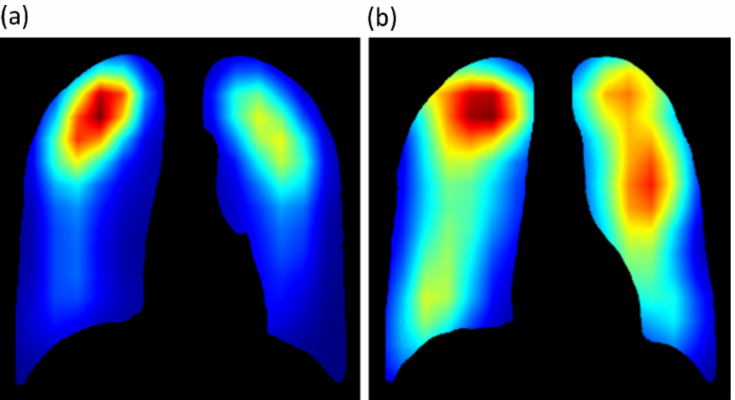
Figure 13. Average CRM computed for the TB class using the ( a ) Shenzhen and ( b ) Montgomery TB CXR